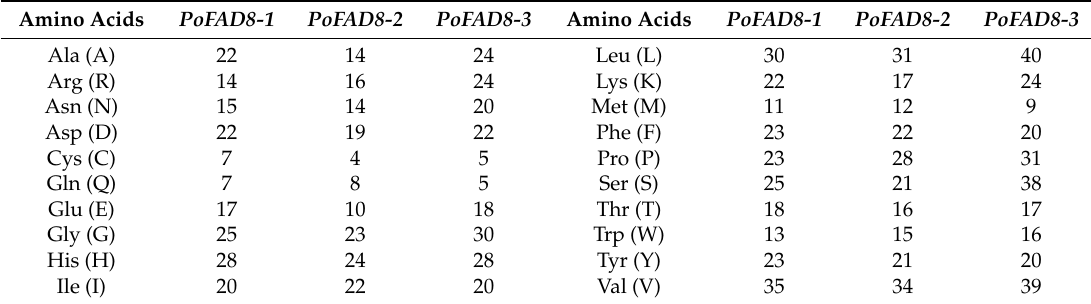
Table 2. Amino acid composition and number of products encoded by cDNAs of PoFAD8-1 , PoFAD8-2 , and PoFAD8-3